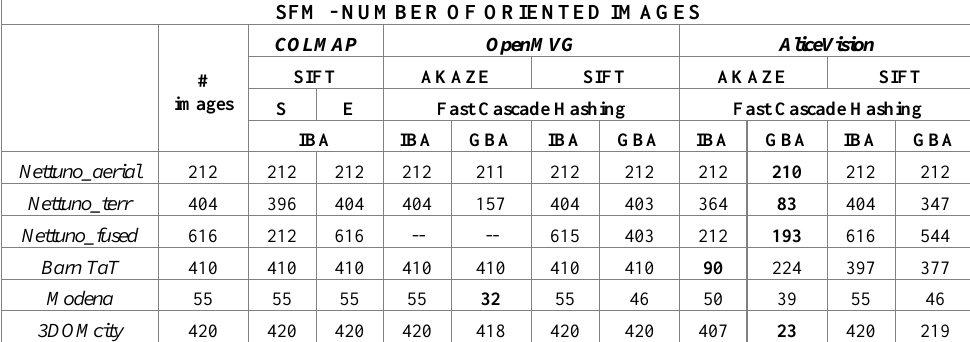
Table 4. Number of oriented cameras for each pipeline. S: sequential keypoint matching; E: exhaustive keypoint matching; IBA: